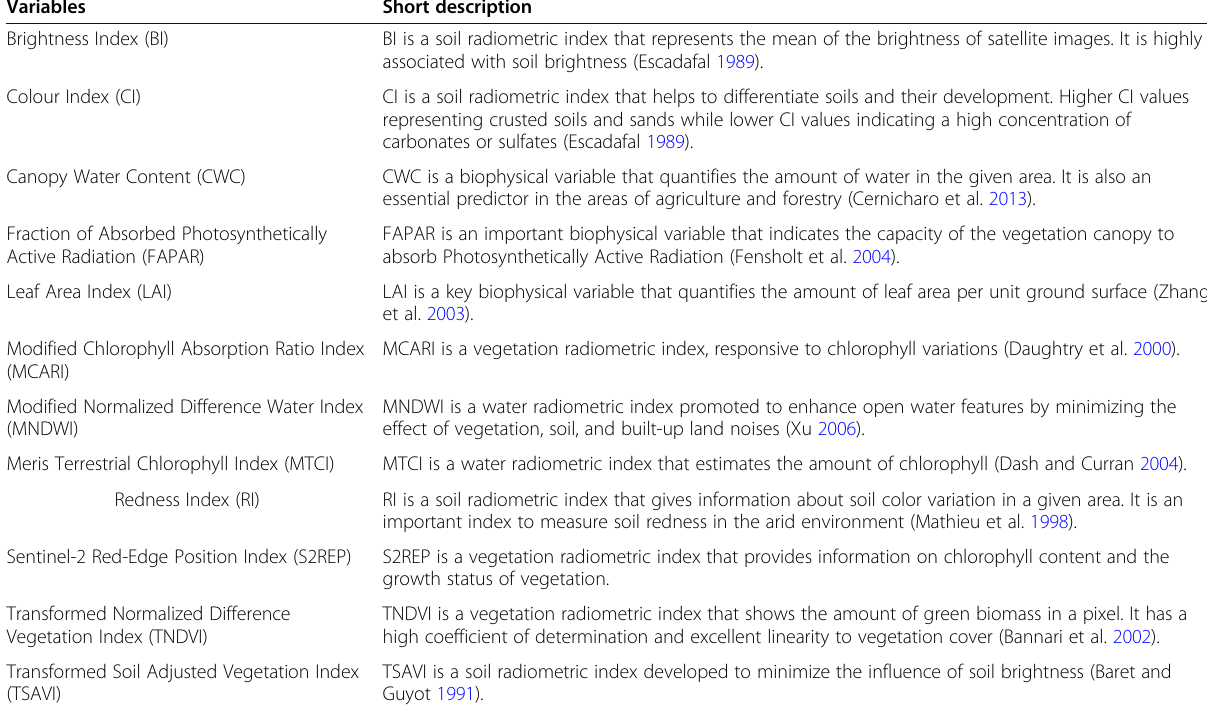
Table 1 Description of the predictive variables used in modelling and mapping the current distribution of invasive Prosopis . The variables were categorized under vegetation indices, soil indices, water radiometric indices, and biophysical variables Variables